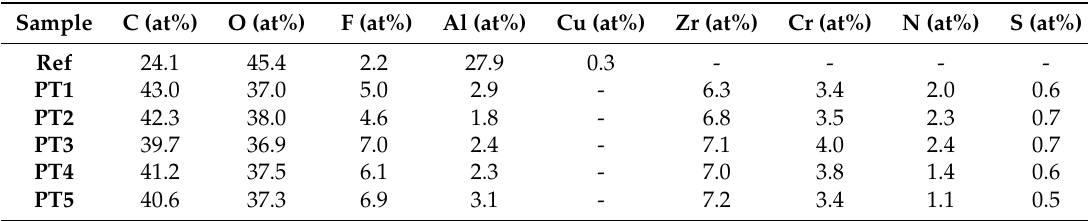
Table 4. Results of the X-ray photoelectron spectroscopy (XPS)-measurements performed on the six aluminium